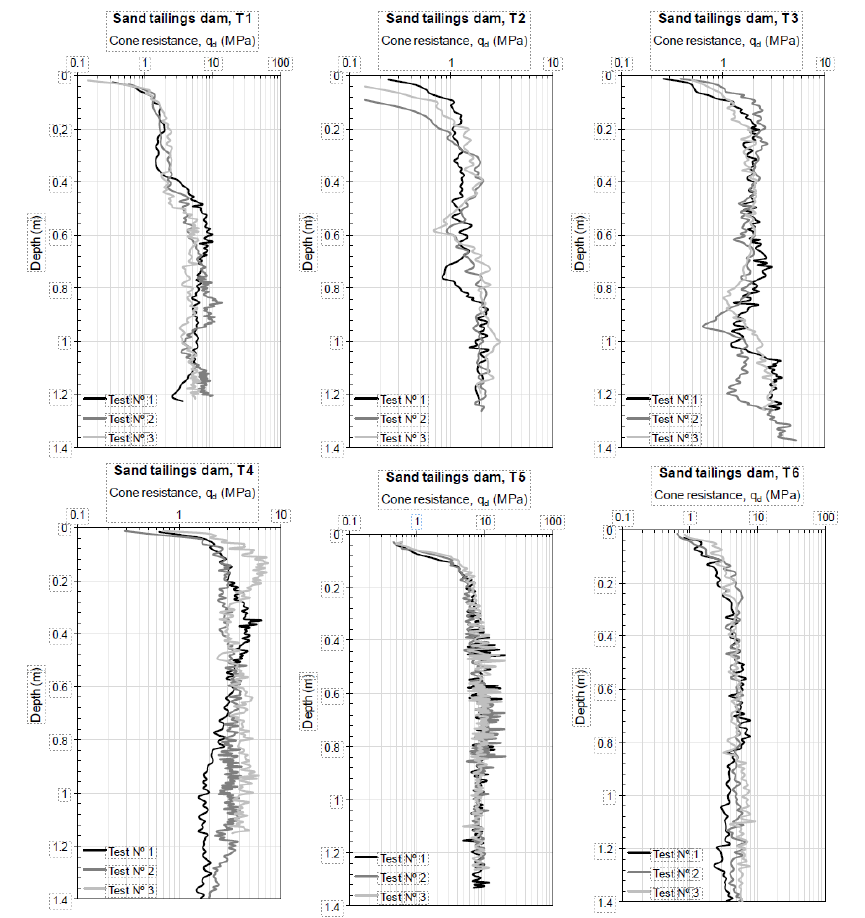
Figure 3. Cone resistance ( q d ) as a function of depth, measured in 6 Chilean clasified sand tail- ings